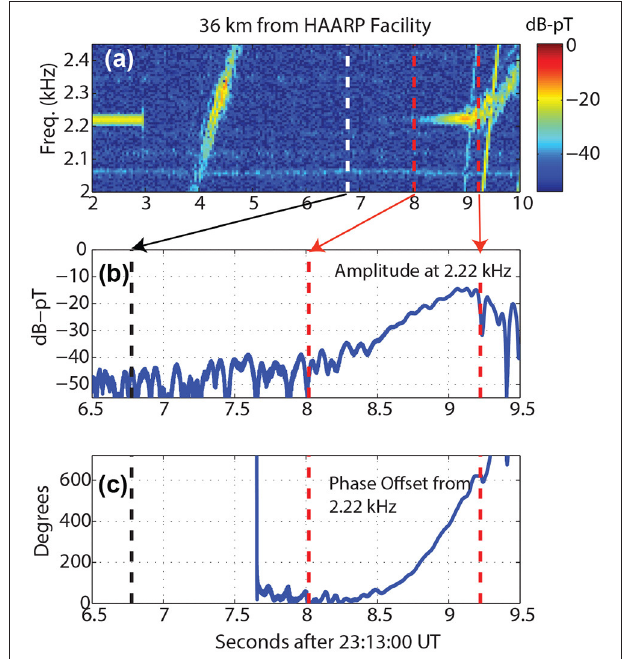
FIGURE 3 | Received two hop echo with triggered emissions due to a monochromatic transmitted pulse from HAARP at 2.22 kHz. (a) Spectrogram of transmitted and received signal, (b) temporal increase in signal amplitude at the transmitted frequency. (c) Exponential phase advance that accompanies the temporal amplitude increase. Features of amplitude and phase dynamics simlar to those shown in Figure 2 for a one hop echo from the Siple Station experiment. The emission at 4 s in the record is from an earlier transmitted frequency-time ramp. Adapted from Figure 3 of Gołkowski et al.